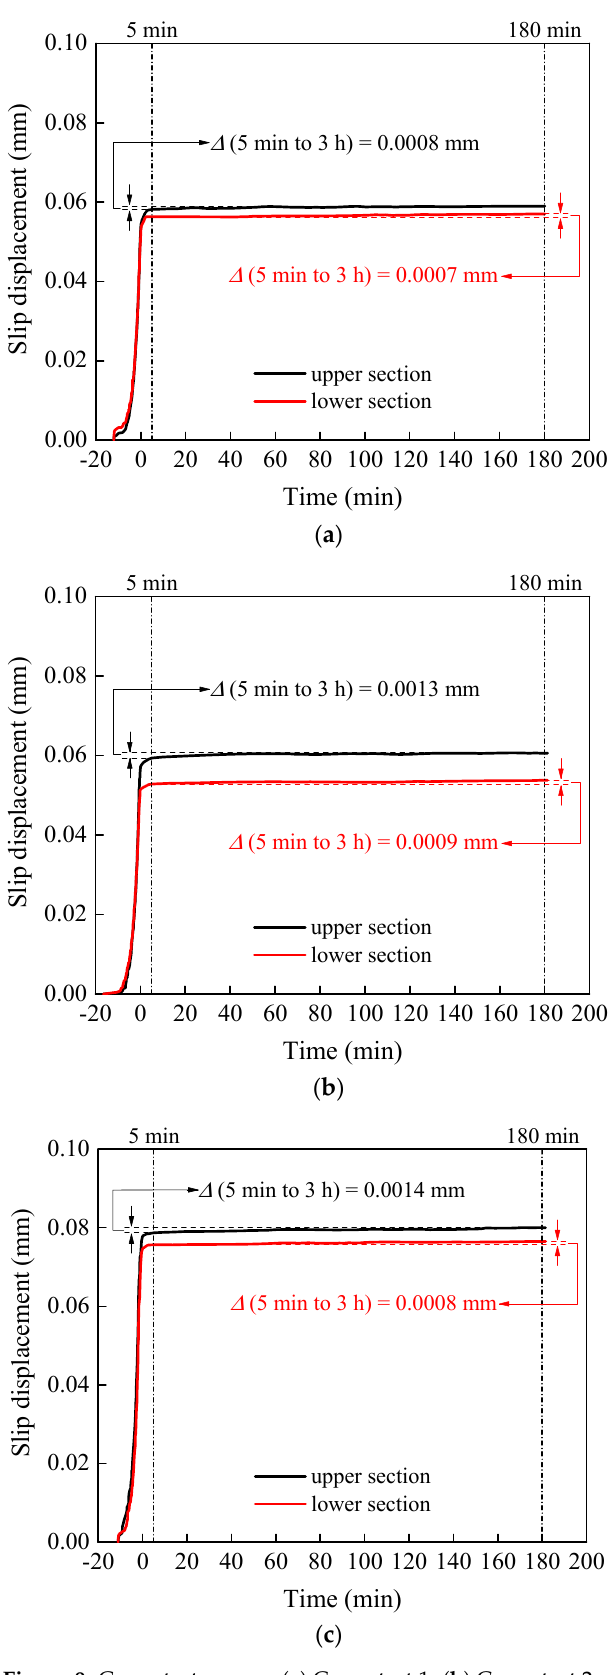
Figure 9. Creep test curves. ( a ) Creep test 1. ( b ) Creep test 2. ( c ) Creep test 3.